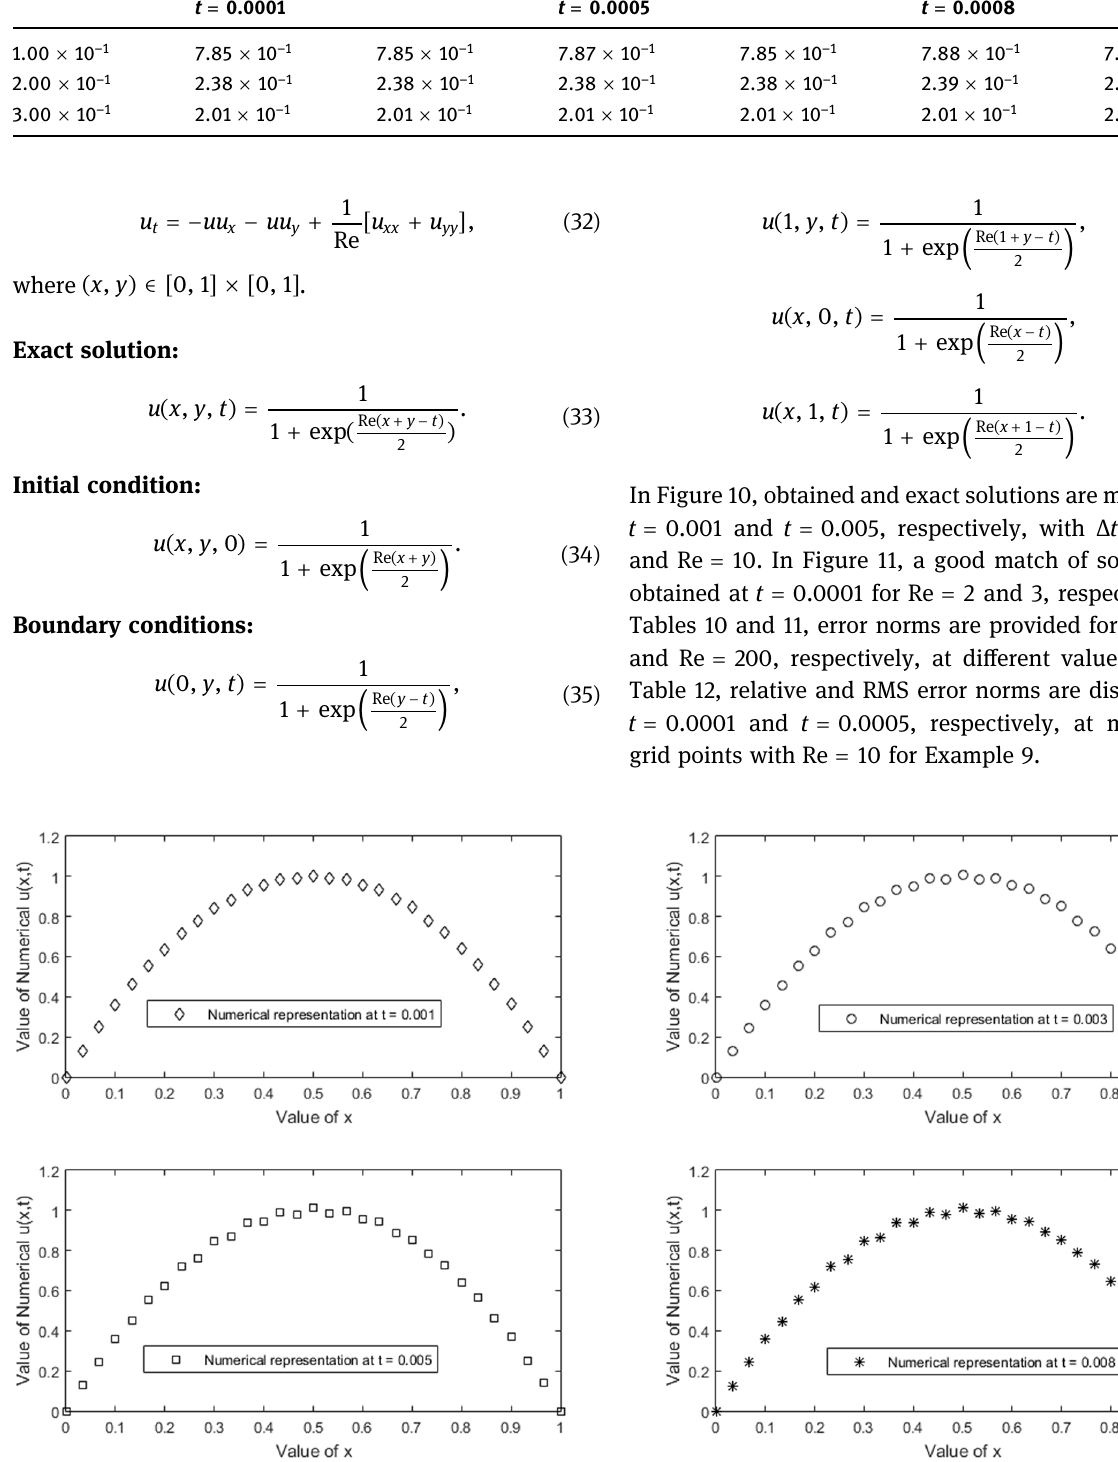
Figure 8: Graphical representation of numerical solution, where = N 101 , = t Δ 0.0001 , = α 1 , and = ν 0.01